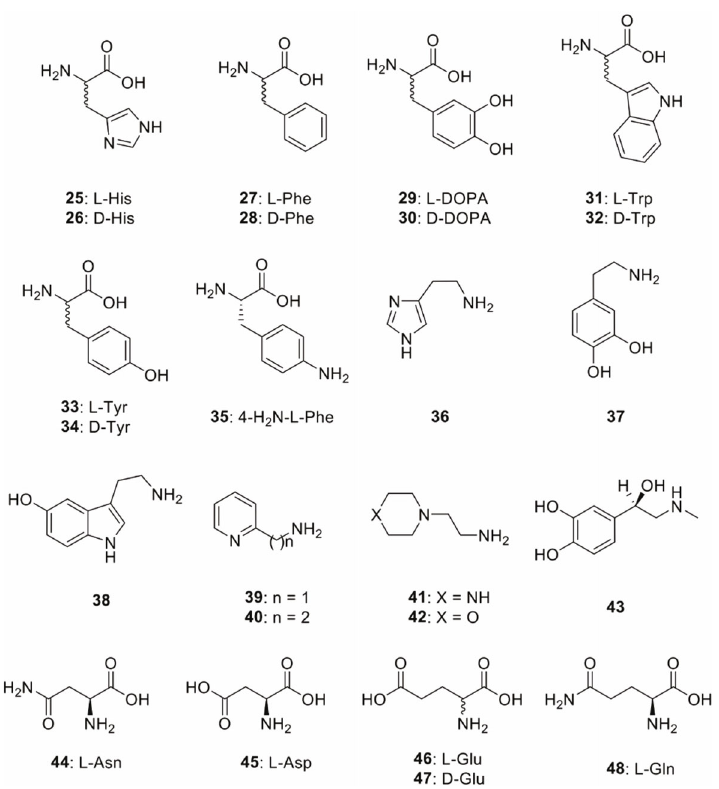
Figure 3: Amino acid and amine activators 25-48 investigated for the activation of several bacterial